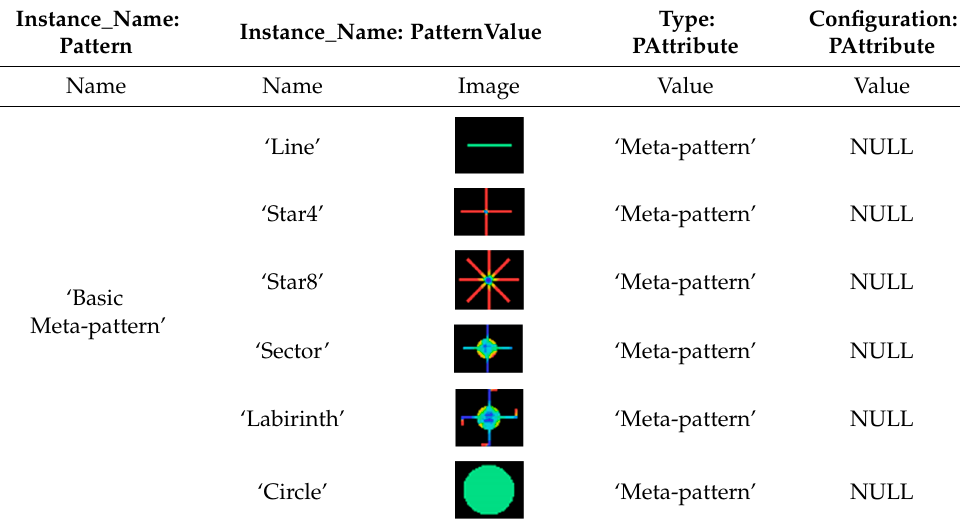
Table 3. Description of basic spatial meta-pattern.